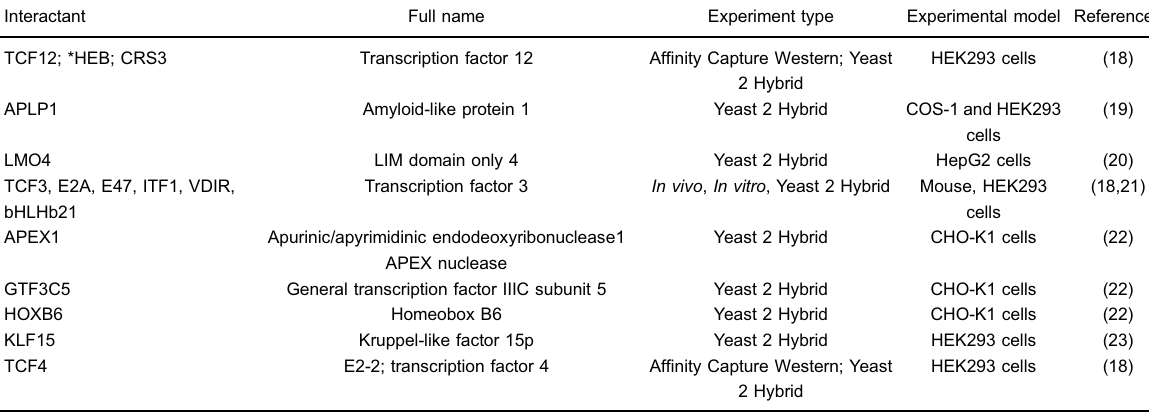
Table 1. Possible interactions of transcription factor 21